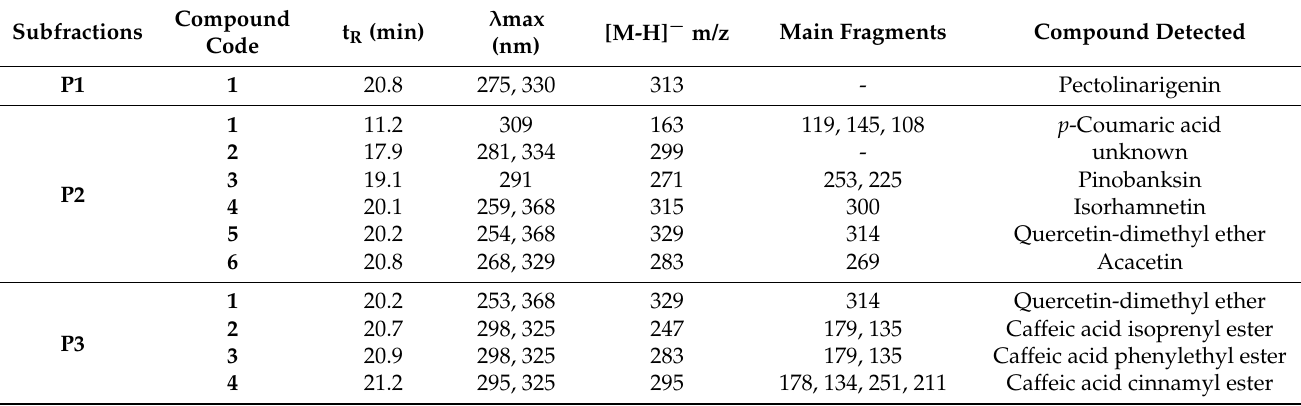
Figure 1. Fractionation of G18.EE and methodologies used for isolation of subfractions and com- pounds from the G18.EE-EtOAc fraction of Portuguese propolis. G18.EE–ethanol extract of propolis from Gerês collected in 2018; EtOAc–ethyl acetate; BuOH–butanol; F–fraction. Table 2. The detection of compounds present in P1 , P2 and P3 , isolated from G18.EE-EtOAc, following LC-MS analysis.